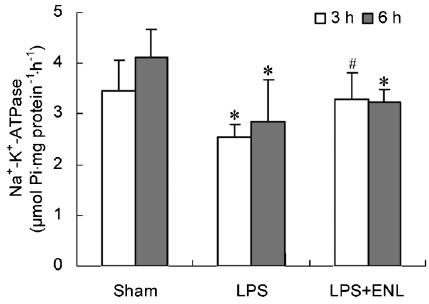
Figure 5. Effect of exogenous normal lymph (ENL) on Na + -K + - ATPase activity of hepatic homogenate in rats. Data are reported as means±SD (n=10). *P , 0.05 vs the sham group; # P , 0.05 vs the lipopolysaccharide (LPS) group (one-way